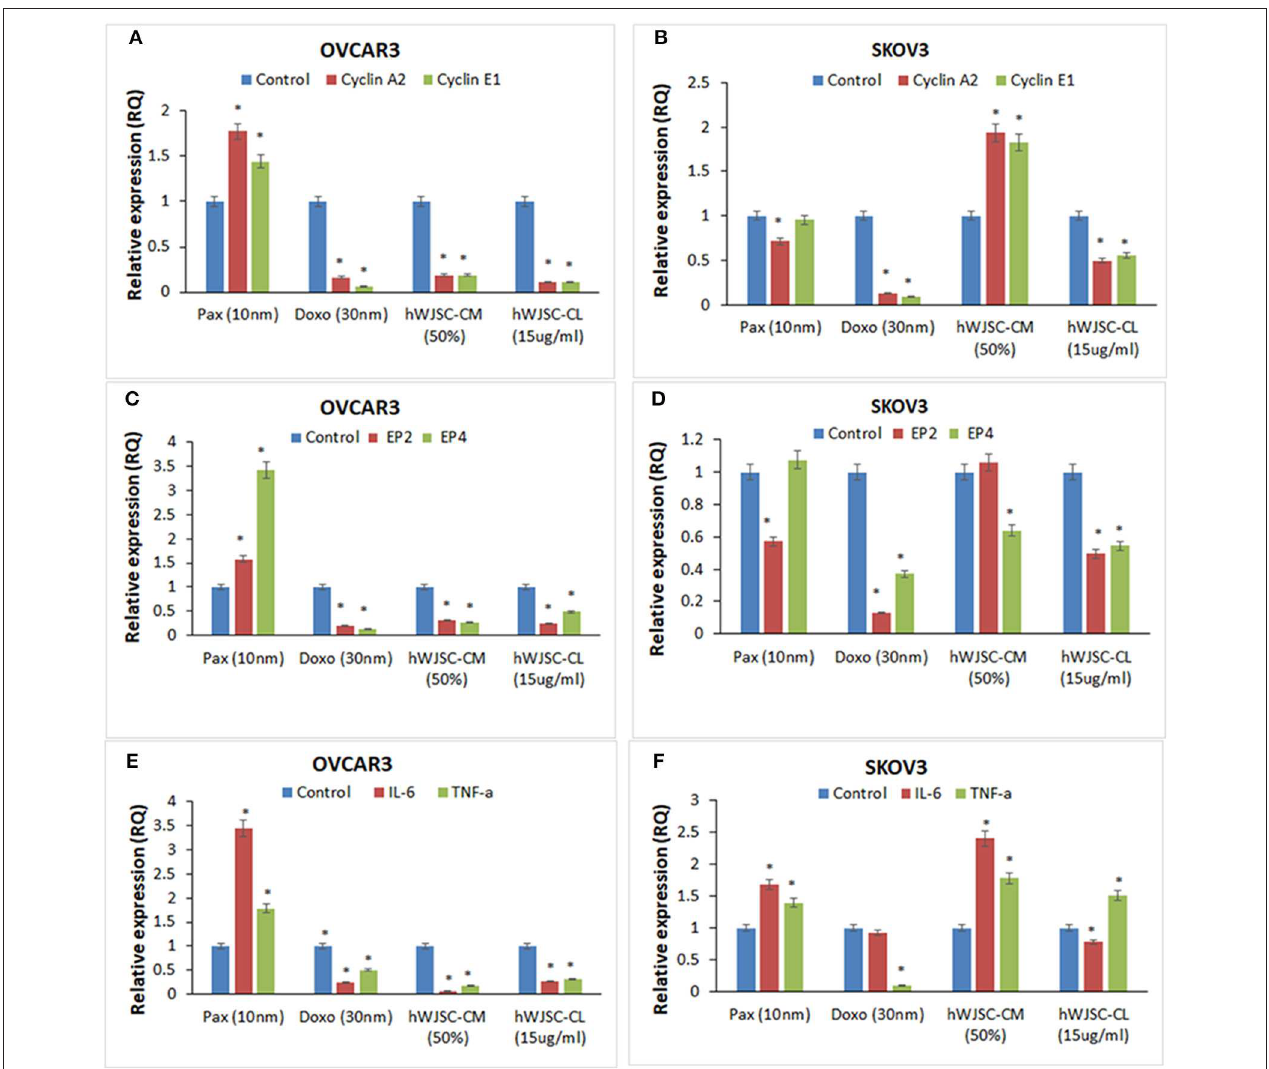
FIGURE 12 | Gene expression analysis of cyclin A2 and cyclin E1 in OVCAR3 and SKOV3 cells (A,B) ; EP2 and EP4 in OVCAR3 and SKOV3 cells (C,D), and IL-6 and TNF- α in OVCAR3 and SKOV3 cells (E,F) using quantitative real-time PCR. Both OVCAR3 and SKOV3 treated with paclitaxel (10nM), doxorubicin (30nM), hWJSC-CM (50%) and hWJSC-CL (15 µ g/ml) for 48h showed decreased expression of cell cycle, prostaglandin receptor and inflammation related genes compared to control. Data analysis and relative quantitation were performed using the comparative Ct method ( 11 Ct). The differences in gene expression levels were analyzed using student’s t -test. Asterisks (*) indicate statistical significance at p <